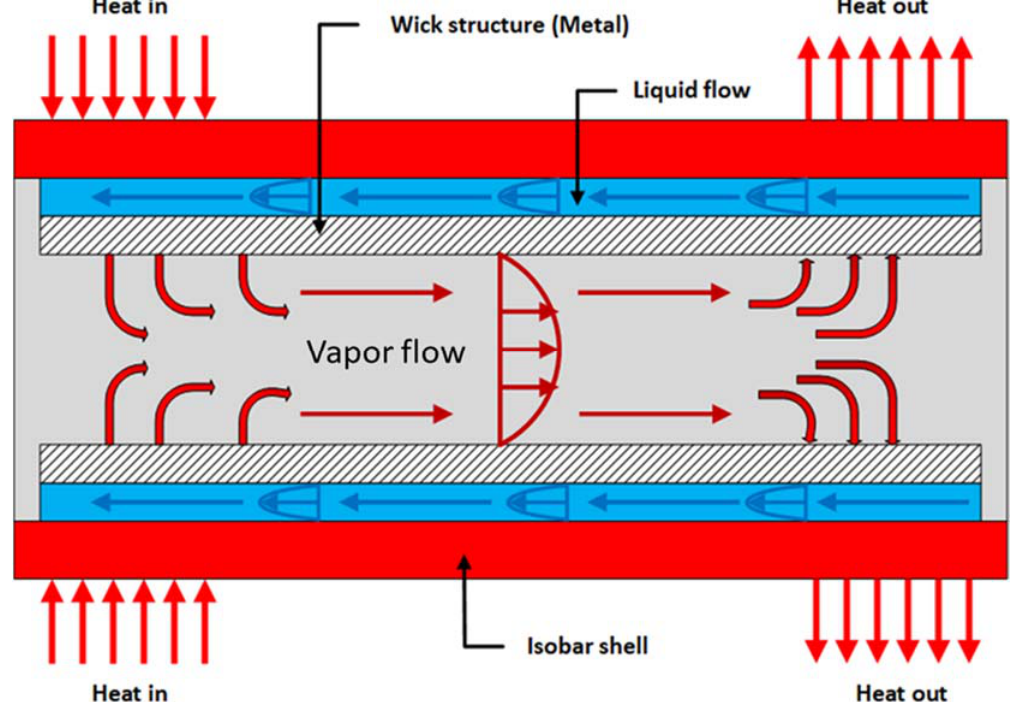
Figure 1. Schematic diagram of heat pipe structure and operation.